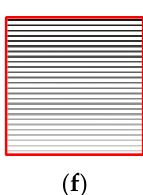
Figure 9. ( a ) Horizontal grating stripes; ( b ) vertical grating stripes; ( c ) horizontal grating fringes obtained by simulating lens distortion; ( d ) vertical grating fringes obtained by simulating lens distortion; ( e ) unwrap the phase of the horizontal fringe to obtain a phase map; ( f ) unwrap the phase of the vertical fringe to obtain a phase map.